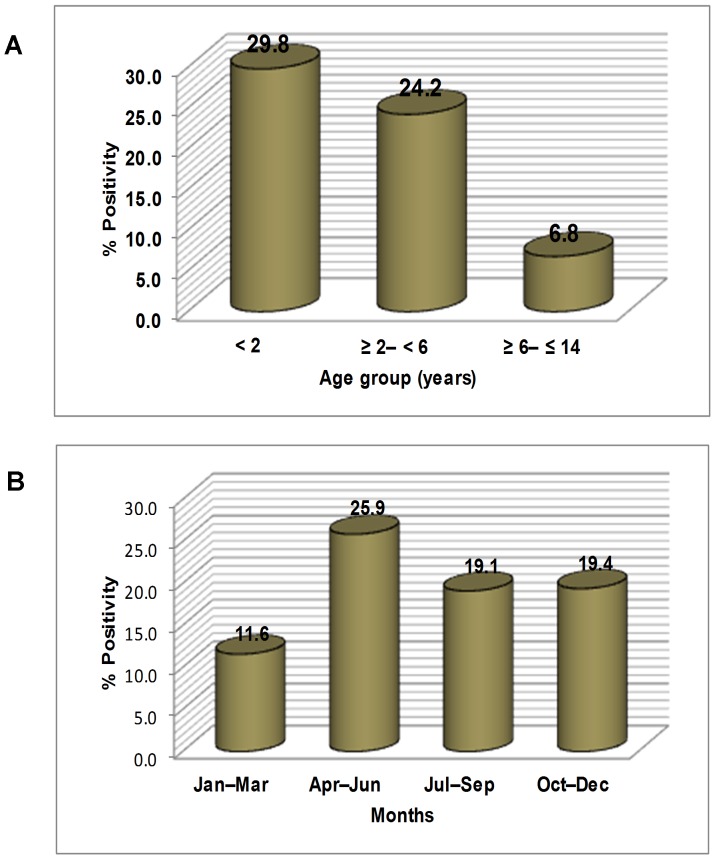
NPEV positivity in AFP cases of the present study.(A) Age-wise distribution. (B) Month-wise distribution.